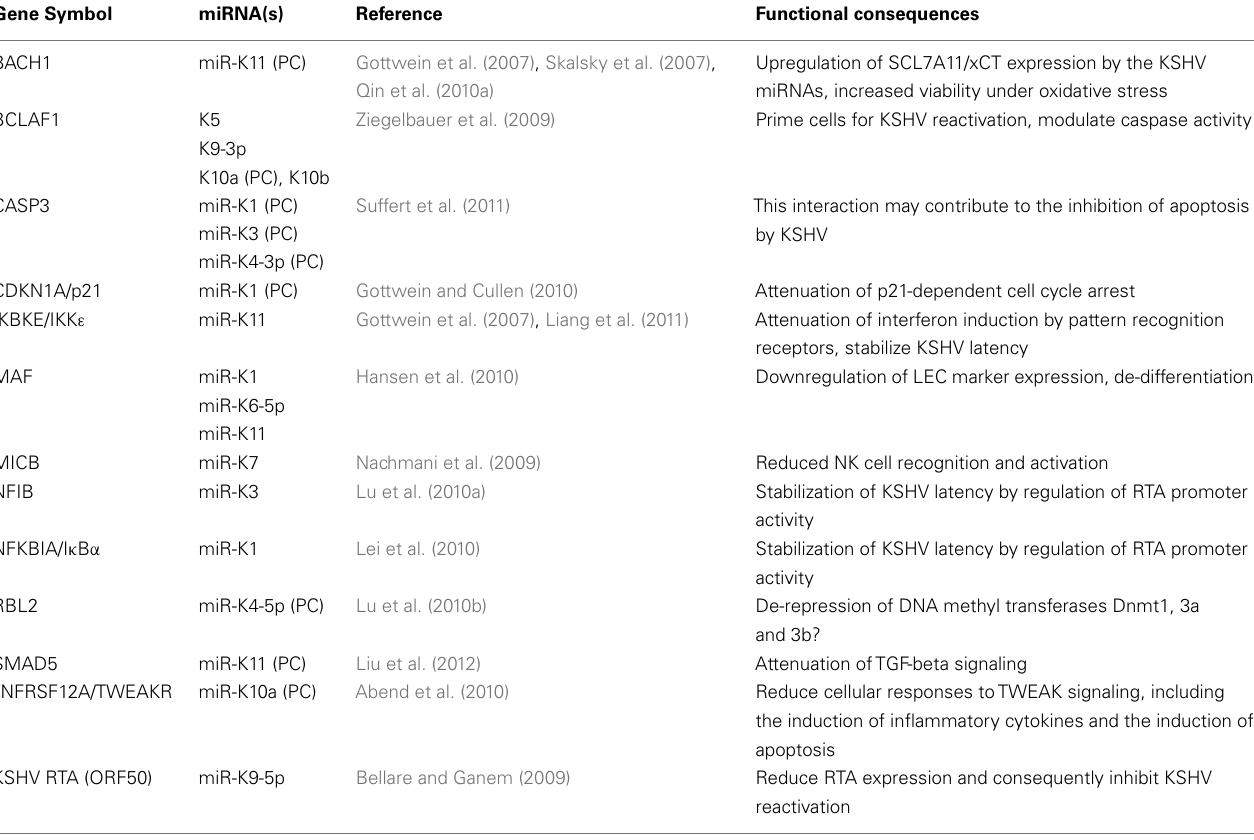
Table 2 | KSHV miRNA